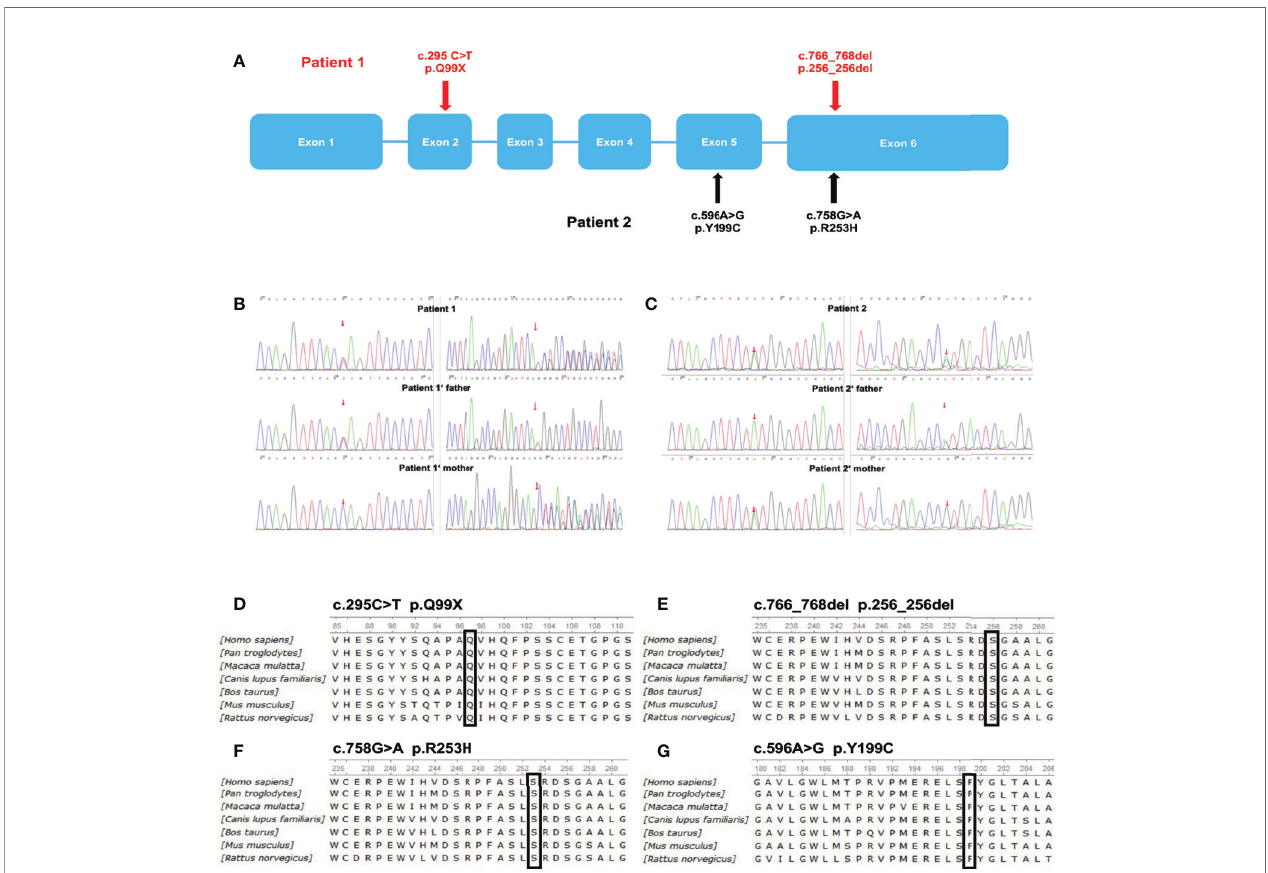
FIGURE 2 | Deletions and point mutations detected by targeted deep sequencing. (A) Schematic representation of G6PC3 gene mutations in the two patients. (B) Sequence analysis of G6PC3 in patient 1, his father, and his mother. (C) Sequence analysis of G6PC3 in patient 2, his father, and his mother. ClustalW alignment of human, chimpanzee, macaque, dog, cow, mouse, and rat G6PC3 protein sequences and mutations detected in patients 1 (D, E) and 2 (F, G) . (D) amino acids 85 – 111, the conserved glutamine at position 99 is highlighted in a black box; (E) amino acids 235 – 261, the conserved methionine at position 256 is highlighted in a black box; (F) amino acids 235 – 261, the conserved arginine at position 253 is highlighted in a black box; (G) amino acids 180 – 206, the conserved tyrosine at position 199 is highlighted in a black